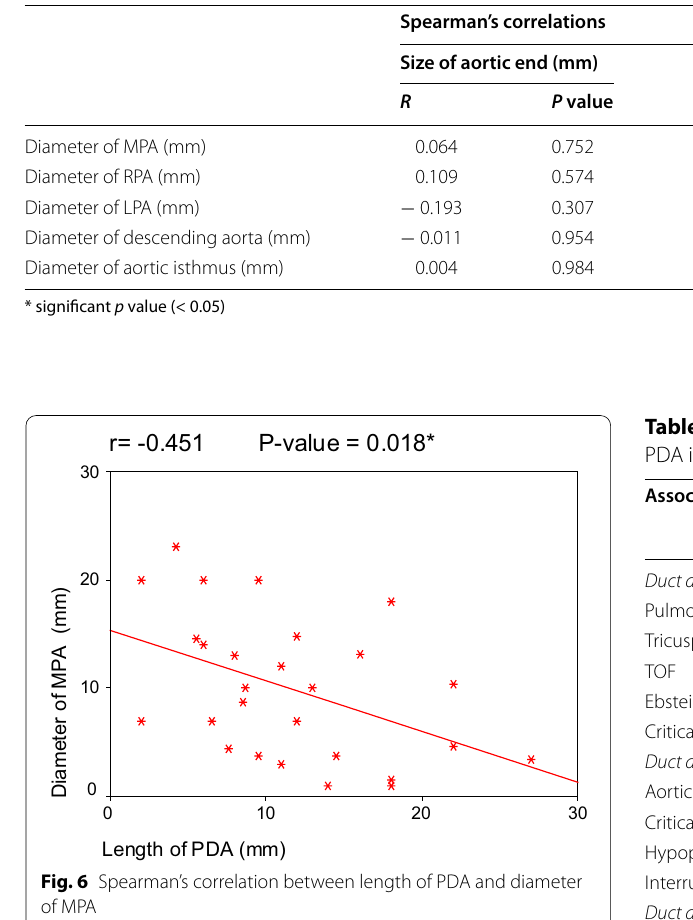
Table 2 Spearman’s correlation between PDA diameters, pulmonary artery, and aortic diameters